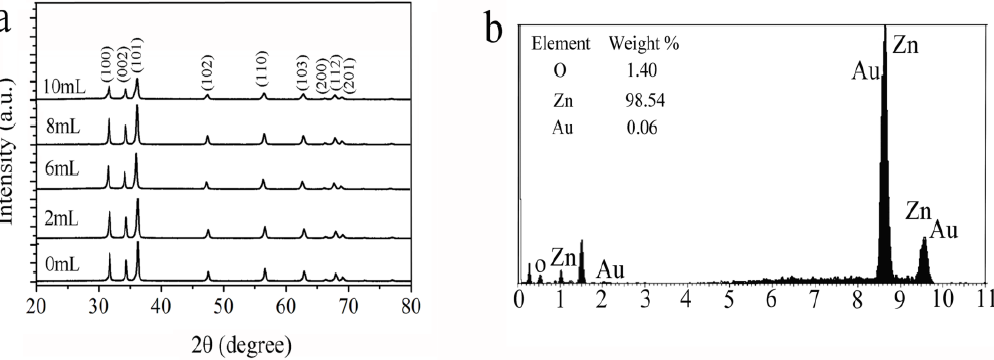
Figure 2. ( a ) XRD analysis of ZnO/AuNPs nanorods synthesized with different ratio of AuNPs. ( b ) EDS spectrum of the ZnO/AuNPs nanorods (Sample 3).